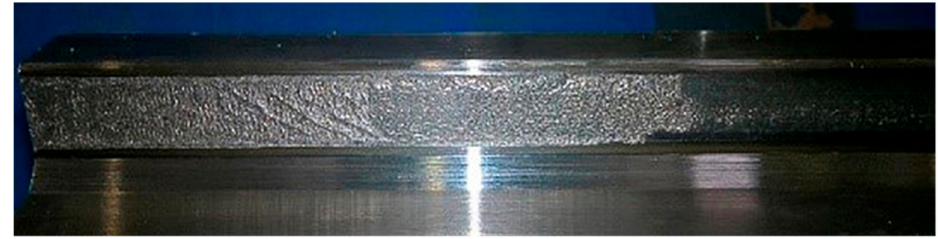
Figure 1. Damage of the guiding profile of linear rolling system.